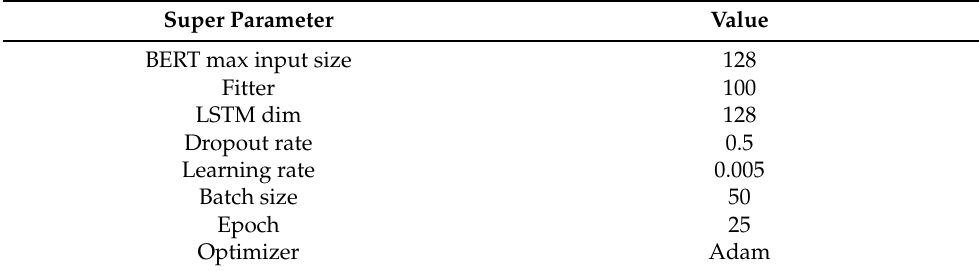
Table 2. Experimental hyperparameter settings (unit: %). Super